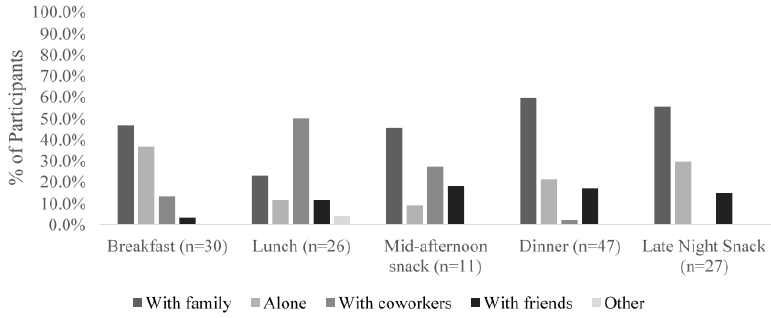
Figure 3. Location of eating for the participants during their reported eating occasion.